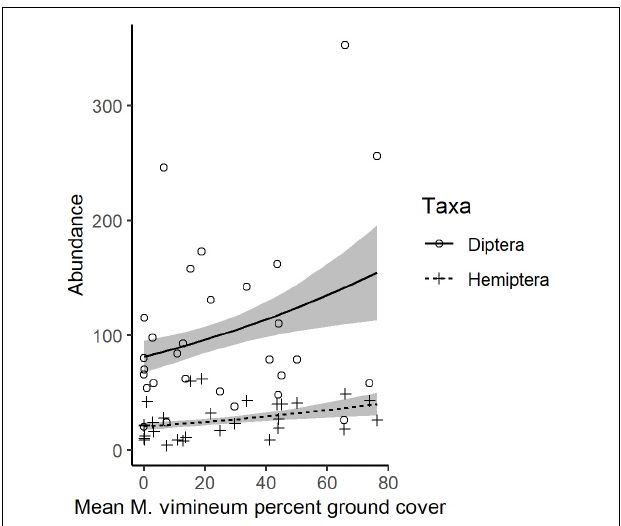
FIGURE 6 | Predicted response of Diptera and Hemiptera with mean percent ground cover of M. vimineum . Points represent raw abundance data, lines depict fitted models, and gray shading represents ± 1